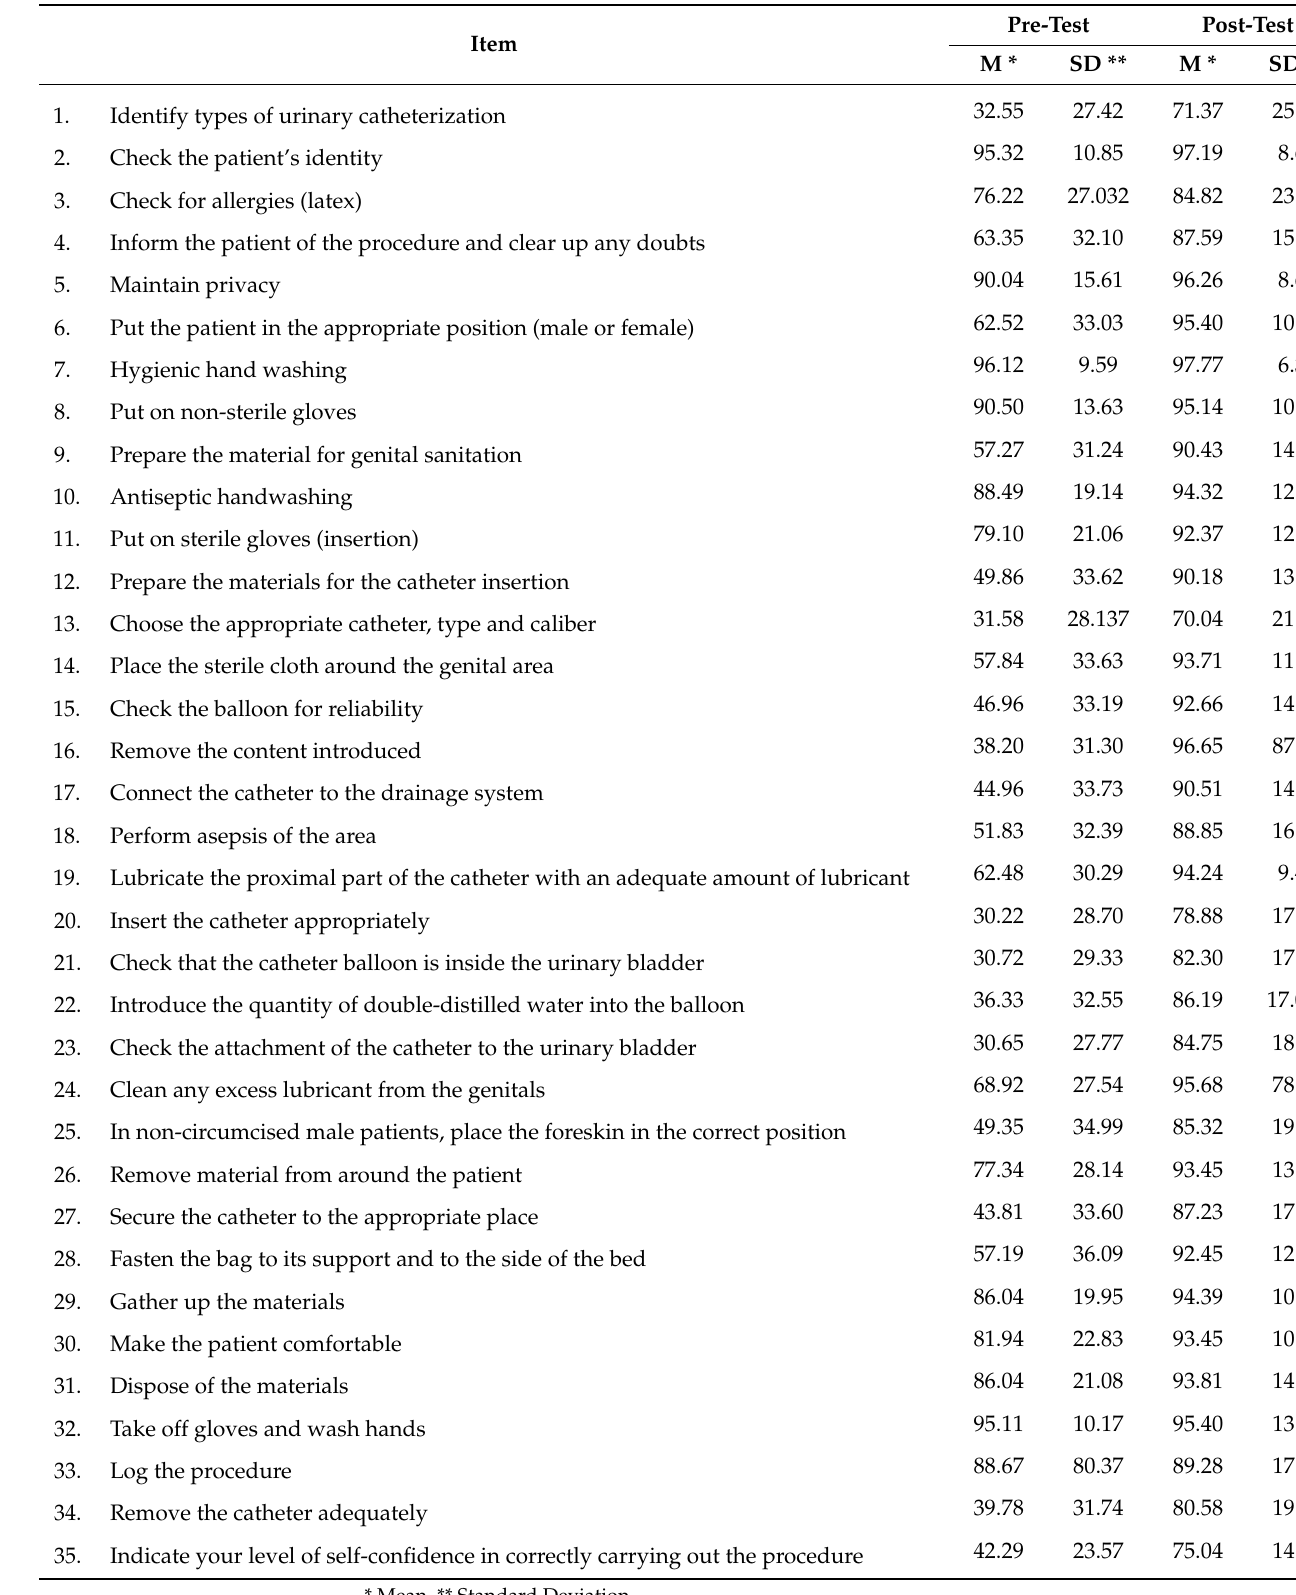
Table 2. Results of the self-efficacy